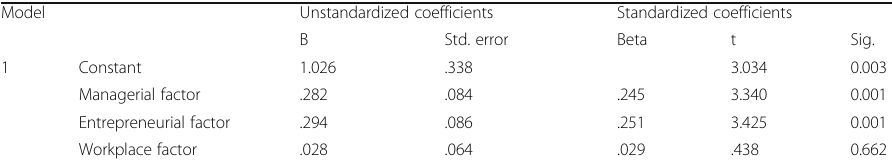
Table 5 Regression model coefficient table Model Unstandardized coefficients Standardized